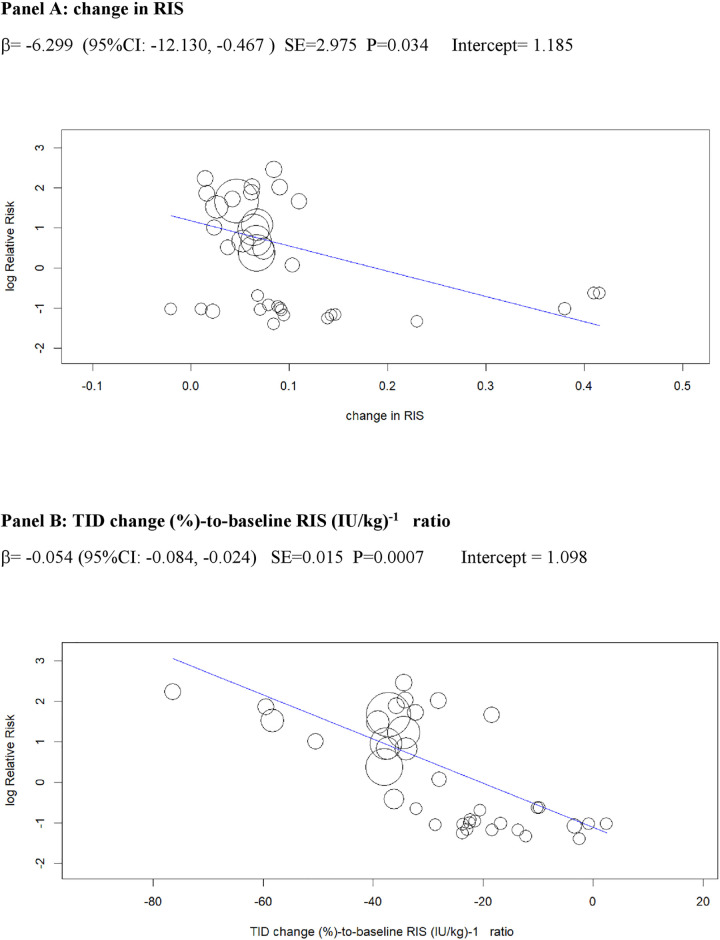
Univariable meta-regression plots for statistically significant moderators of the RR of DKA: Change in RIS and in TID (% change)-to-baseline RIS (IU/kg)−1 ratio.DKA, diabetic ketoacidosis; RIS, relative insulin; RR, risk ratio; TID, total insulin dose.